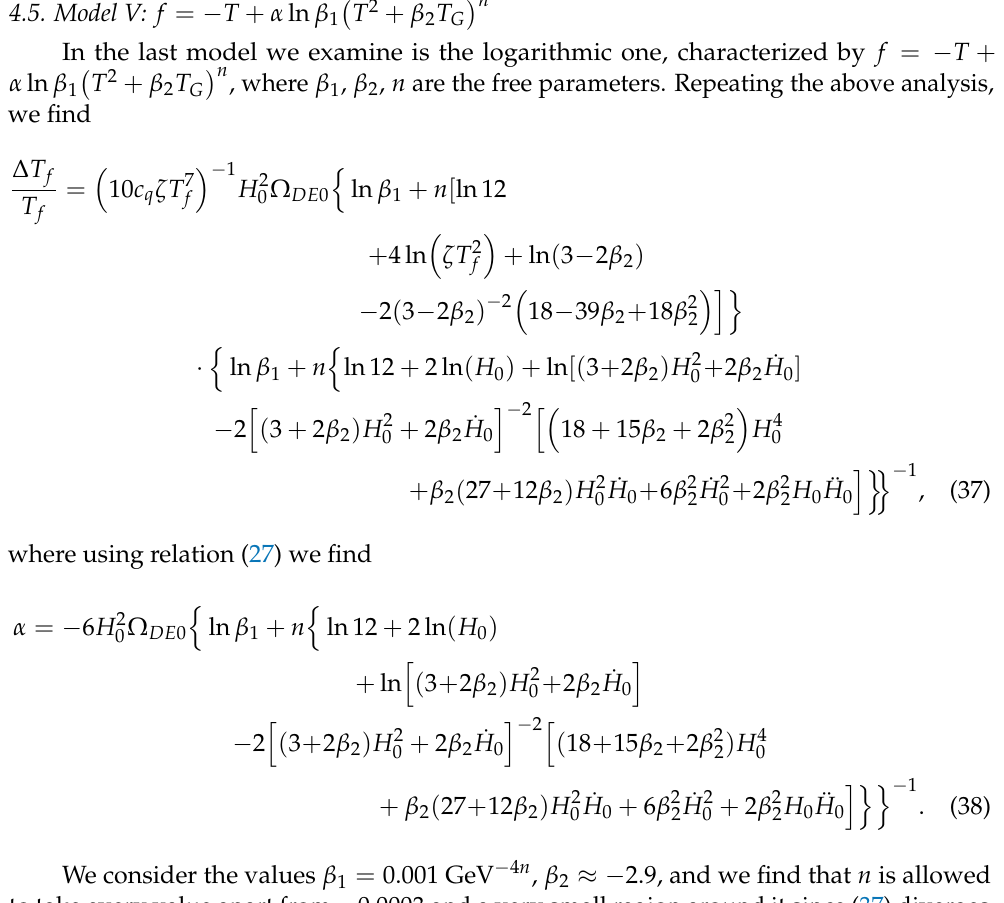
Figure 2. | ∆ T f / T f | vs. the model parameter n (blue solid curve), for Model IV: f = − T + (cid:0) (cid:1) n T 2 + β 2 T G β 1 with β 2 ≈ − 2.90, and the upper bound for | ∆ T f / T f | from (26) (red dashed line). As we observe, constraints from BBN require n (cid:46)